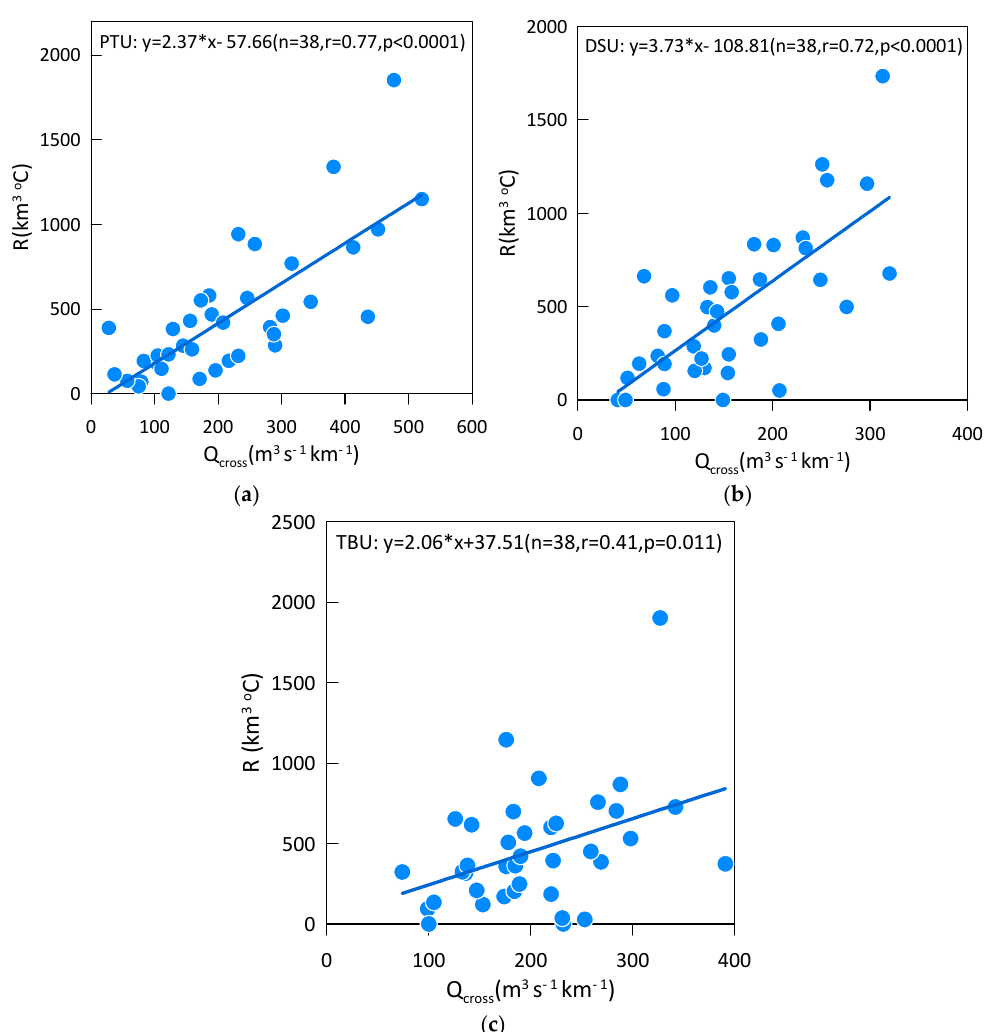
Figure 6. Relationship between the cross − shore Ekman transport (Q cross ) and upwelling intensity ( R ) in PTU ( a ), DSU ( b ), and TBU ( c ).